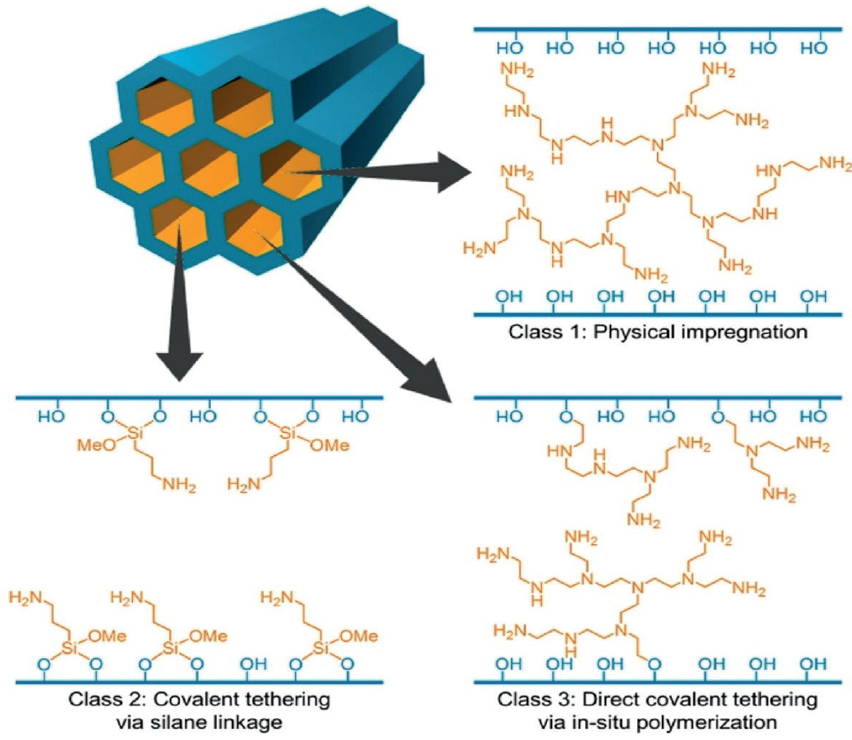
Figure 6. Classification of amine-functionalized sorbents. Reproduced with the permission from [6]. Class I Amine-Functionalized Sorbents